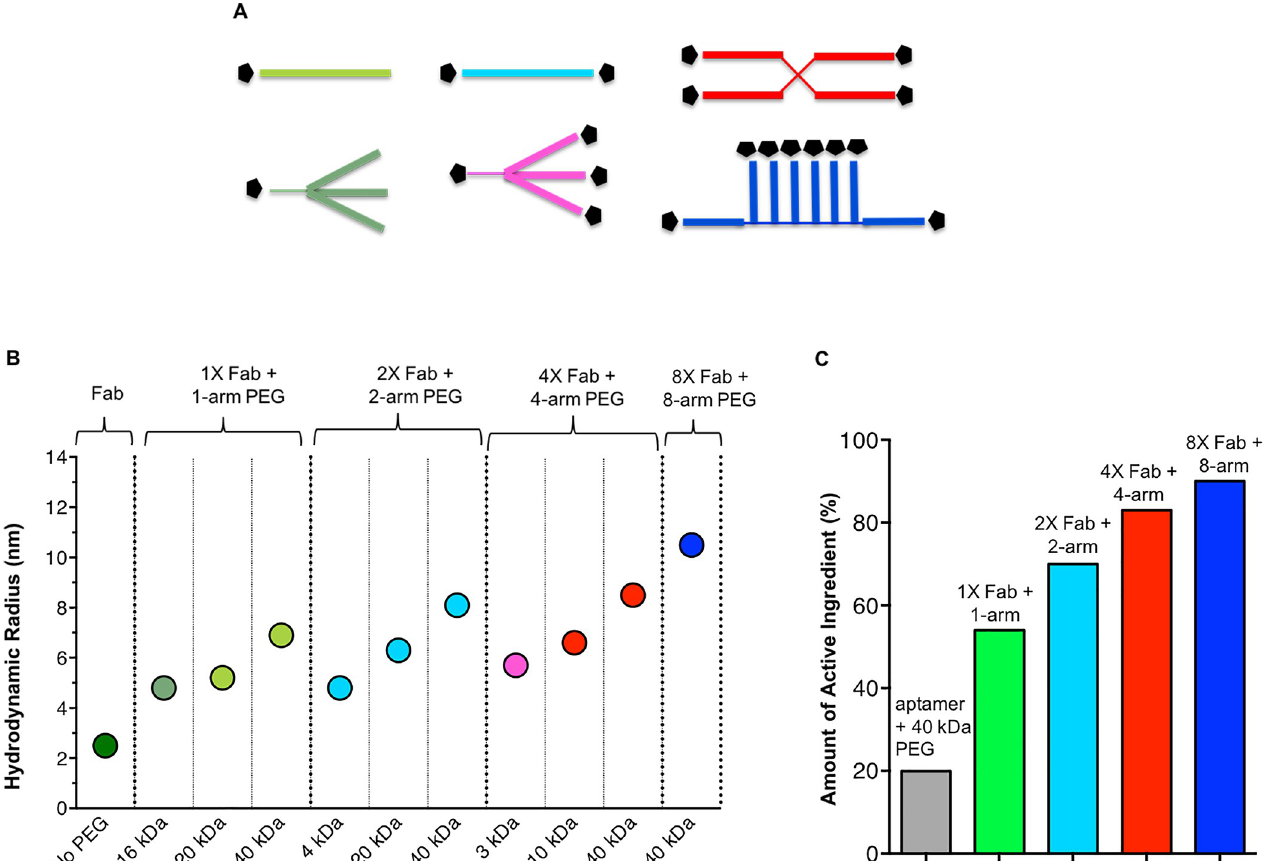
Fig 2. A. Schematic representation of the types of PEGs used. B. R H values were used to rank the Fab + PEG conjugates. The conjugates are organized first in ascending degree of branching, and in increasing MW within each group. C. Increasing degree of PEG branching maximizes Fab content and decreases PEG burden in the eye. 40 kDa 4-arm and 8-arm PEG molecules increase R H beyond 40 kDa linear PEG, while also decreasing PEG burden. Pegaptanib (Macugen) is an aptamer conjugated to 40 kDa PEG.